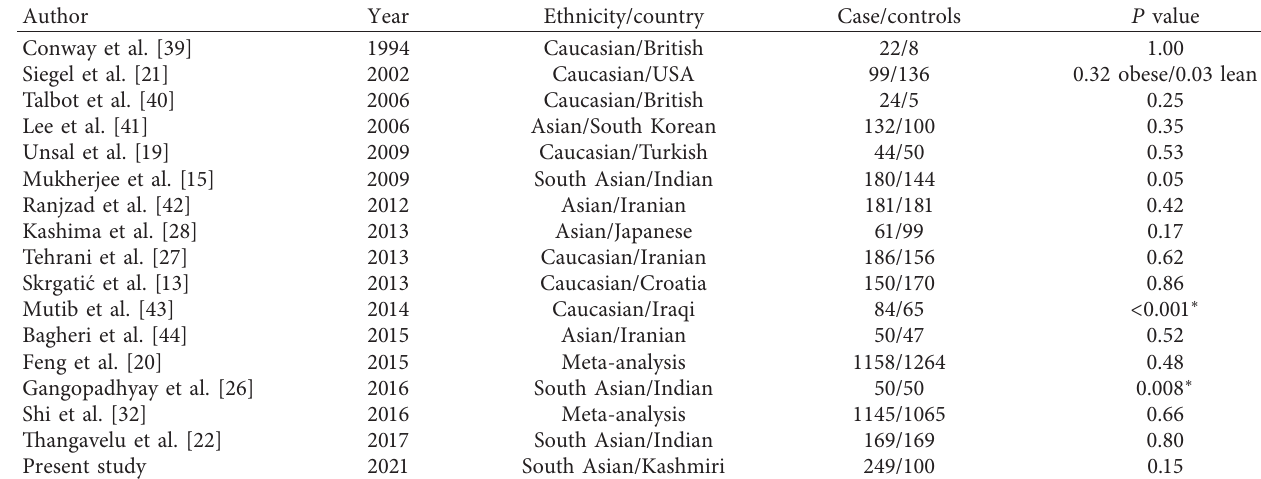
Table 4: Comparison of the present study with previous studies of INSR gene exon 17 C/T (rs1799817) polymorphism and PCOS.